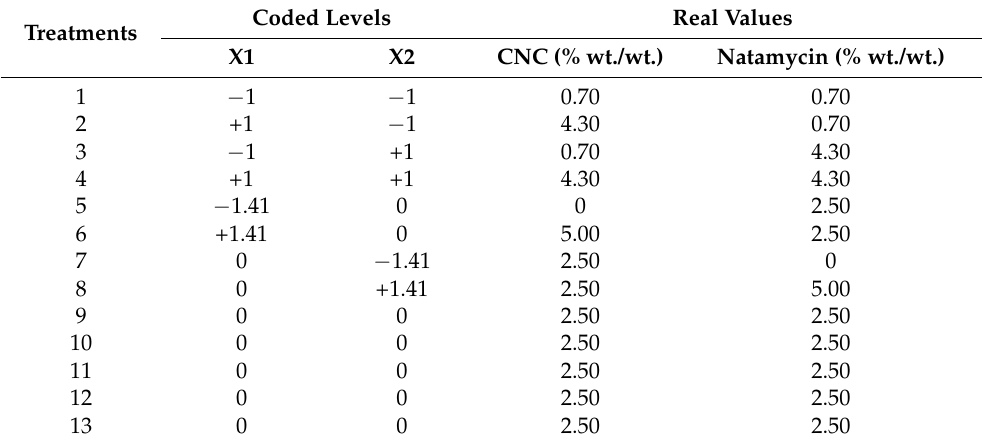
Table 1. Composition of the two-factor five-level RCCD of the elaborated films incorporated with cellulose nanocrystals (CNC) and natamycin. Coded levels and their respective real values. Coded Levels Real Values Treatments X1 X2 CNC (% wt./wt.) Natamycin (% wt./wt.) 1 − 1 −